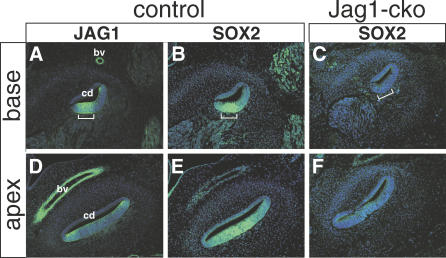
At E12.5 JAG1 Is Expressed within the Prosensory Domain and SOX2 Expression Is Down-Regulated within This Domain in Jag1-cko Cochleae(A, B, D, and E) Alternate sections from a control embryo processed for immunocytochemistry using antibodies against either JAG1 or SOX2. Note the similar domain occupied by both JAG1 and SOX2 in the base of the cochlea (A and B; brackets). In the apical region, the two proteins are not colocalized (D and E). SOX2 is not expressed in the basal portions of the Jag1-cko cochlea (C) and shows only weak expression in the apex (F). bv, blood vessel; cd, cochlear duct.